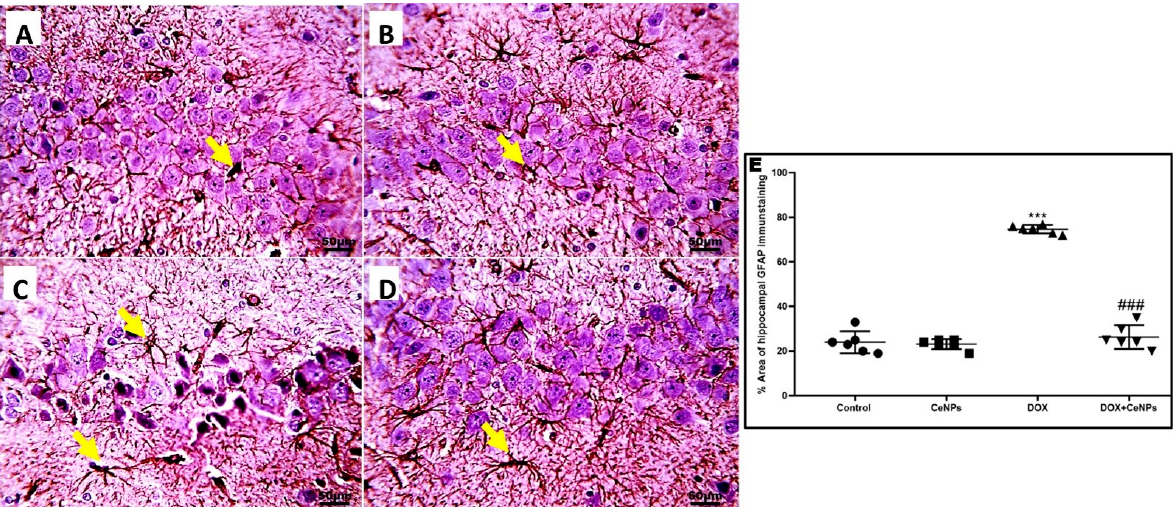
Figure 7. A. Microscopic pictures of immunostained sections of hippocampal sections against GFAP showing normal numbers of positively brown stained astrocytes in pyramidal layer (CA3) in the both ( A , B ) control group and group which received CeNPs. ( C ) Hippocampal sections from DOX group showed increased numbers and branches of positively brown stained astrocytes (yellow arrows). ( D ) Hippocampal sections from treated group DOX + CeNPs showed decreased numbers and branches of positively brown stained astrocytes (yellow arrows). ( E ) Histogram of % area of im- munostaining hippocampal GFAP, values were expressed as mean ± SD. One-way ANOVA with Tukey’s post hoc analysis was performed. *** p < 0.001 significant vs. control group ### p < 0.001 significant vs. DOX group. Magnification × 400. Scale bar = 50 µ